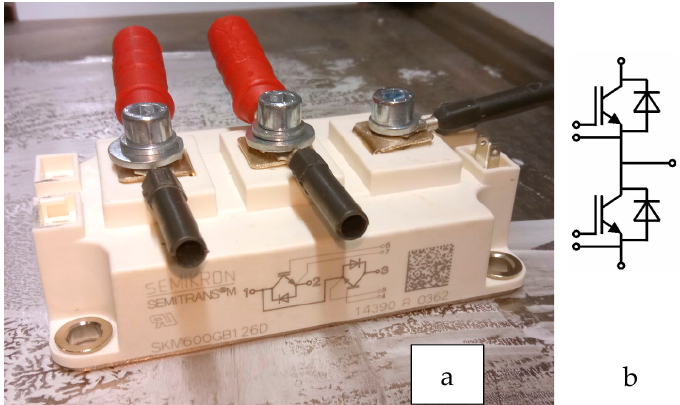
Figure 21. IGBT module on a cold plate on a wet surface ( a ); circuit scheme ( b ).